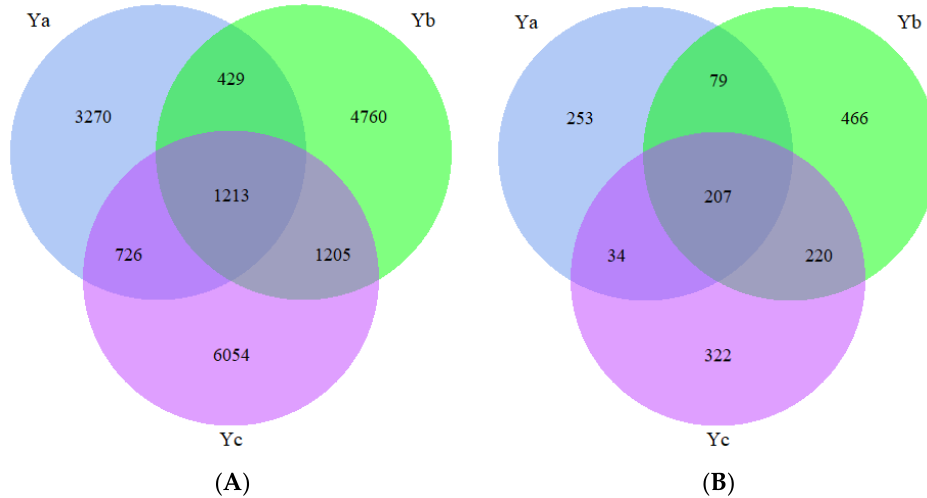
Figure 1. The shared and unique OTUs of phyllosphere bacteria ( A ) and fungi ( B ). Ya: healthy Pinus tabuliformis trees; Yb: diseased P. tabuliformis trees at an early stage of B. xylophilus infection; Yc: diseased P. tabuliformis trees in the last